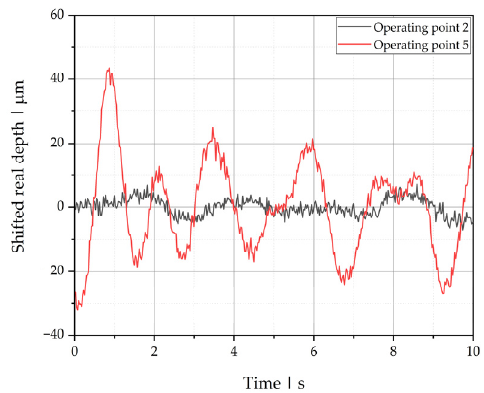
Figure 11. Real depth position of the polymer-polymer interface over time, shifted by the mean, for operating points 2 (stable) and 5 (unstable).